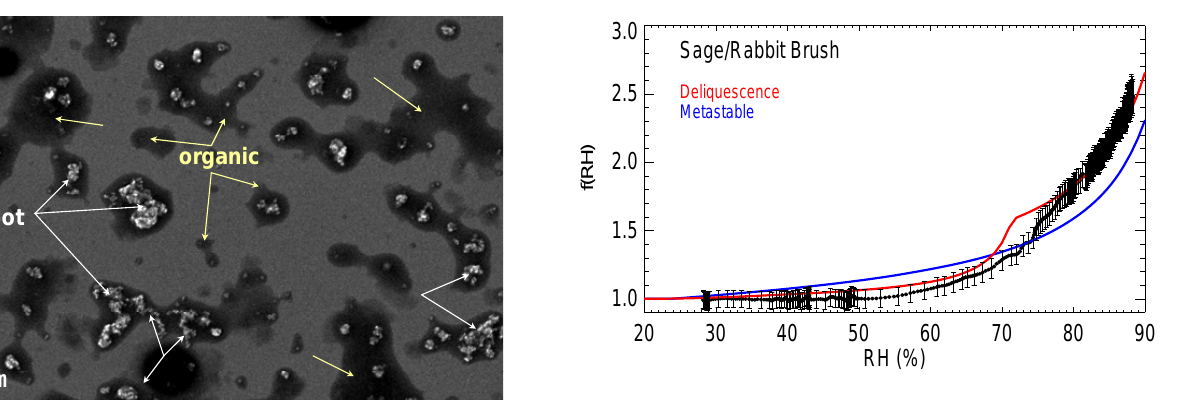
Fig. 6. Measured and modeled humidification factors ( f (RH)) as Figure 6. Measured and modeled humidification factors ( f (RH)) as a function of relative a function of relative humidity (RH, %) for particles emitted from humidity (RH, %) for particles emitted from Utah sage/rabbit brush burns. The f (RH) Utah sage/rabbit brush burns. The f (RH) results derived from the results derived from the E-AIM model are for deliquescence and metastable equilibrium. E-AIM model are for deliquescence and metastable equilibrium. Measurements and model calculations performed at a wavelength of 530 nm. Measurements and model calculations performed at a wavelength of